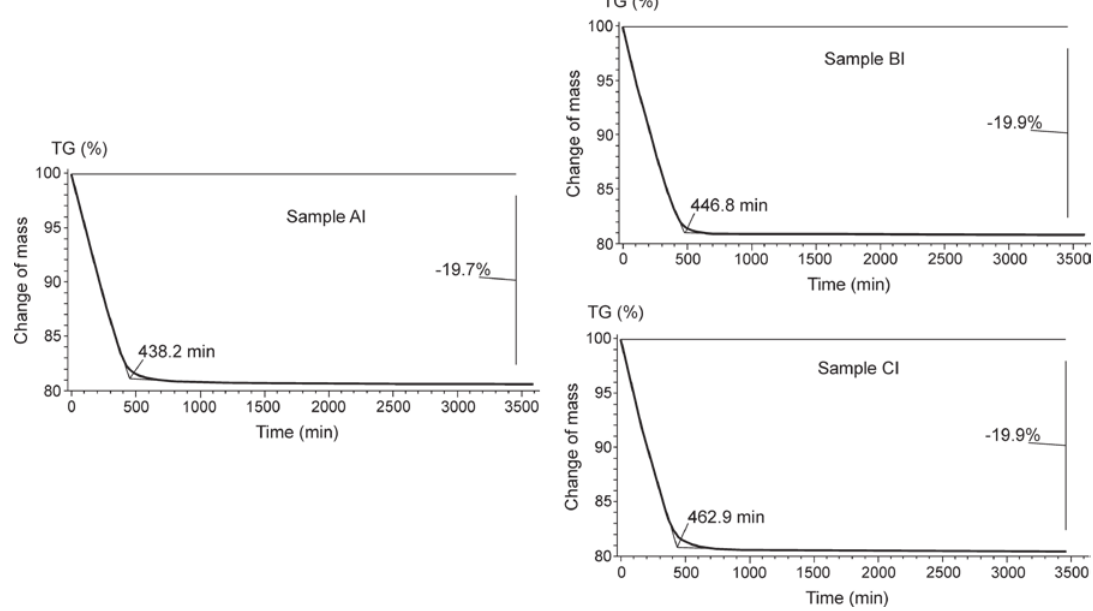
Figure 8 Mass degradation of AI, BI and CI according TGA.